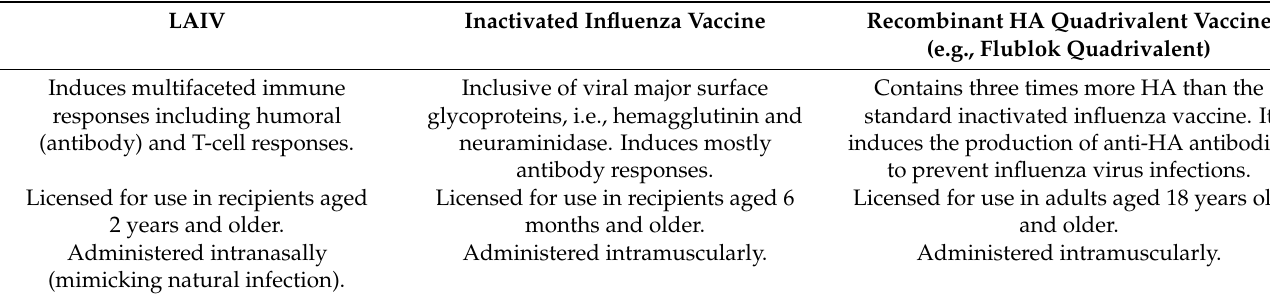
Table 1. Comparison between LAIV and inactivated influenza